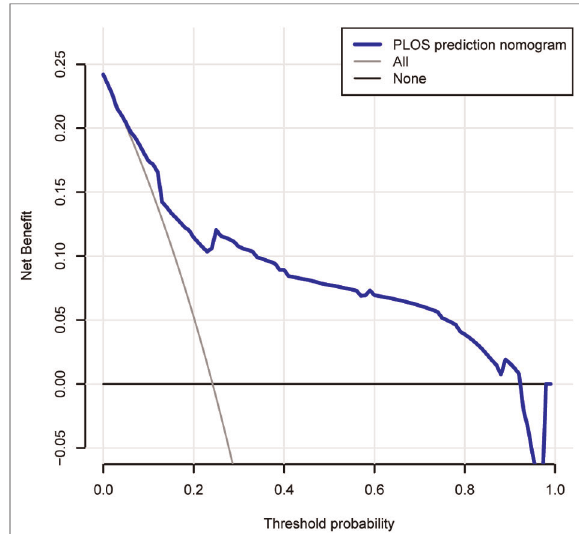
FIGURE 6 Decision curve analysis for the prolonged PLOS prediction nomogram. The y -axis measures the net bene fi t. The dotted line represents the prolonged PLOS prediction nomogram. The thin solid line represents the assumption that all patients have prolonged PLOS. The thin thick solid line represents the assumption that no patients have prolonged PLOS. The decision curve shows that if the threshold probability of a patient and a doctor is 3% and 92%, respectively, using this prolonged PLOS prediction nomogram in the current study to predict prolonged PLOS risk adds more bene fi t than the intervention-all-patients scheme or the intervention-none